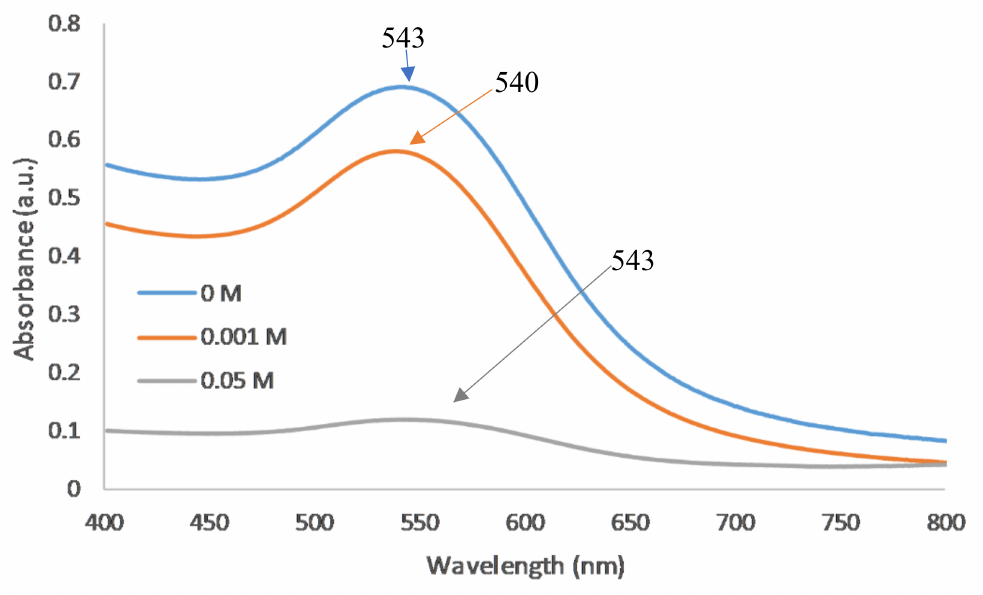
Figure 3. UV–vis spectra of varying salt concentrations of 5 mg/mL PDADMAC on 5 nm